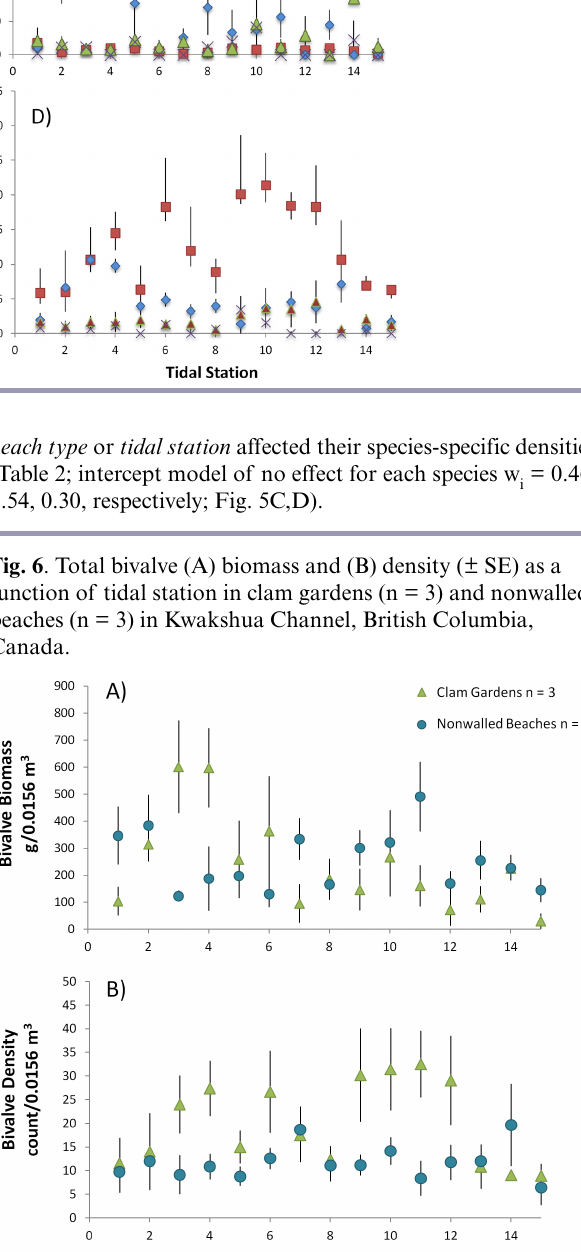
Fig. 5 . Variation in species-specific bivalve biomass and density (± SE) as a function of tidal station in (A and C) nonwalled beaches (n = 3) and (B and D) clam gardens (n = 3) in Kwakshua Channel, British Columbia, Canada. Unique symbols and colors represent different species of clams: Butter clam ( Saxidomus gigantea ), bentnose macoma ( Macoma